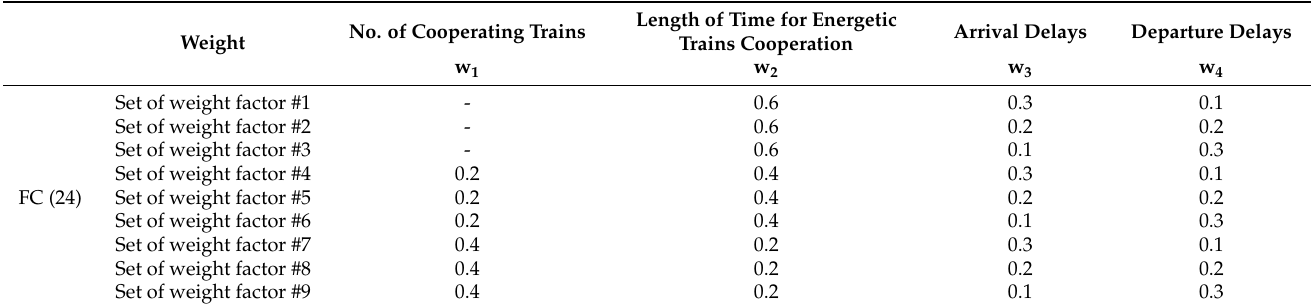
Table 3. Sets of weight factors for optimization (24).